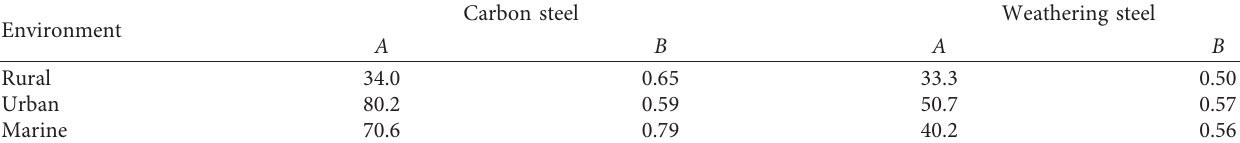
Table 1: Average values of corrosion parameters A and B for carbon and weathering steel.